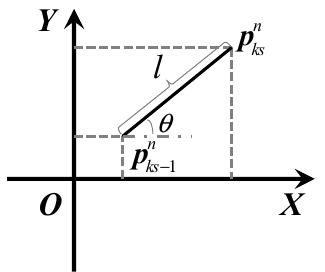
Figure 4. The principle of deck reckoning method.